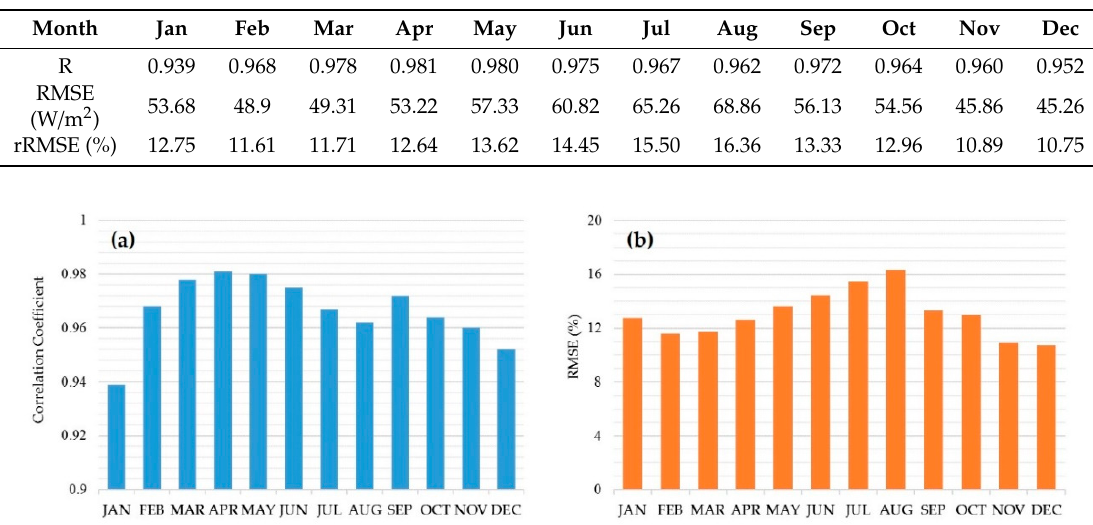
Figure 8. Monthly accuracy of the temporal validation of the ANN model represented by ( a ) R and ( b ) rRMSE (%) . Table 3. Monthly accuracy of the temporal validation of the ANN model.